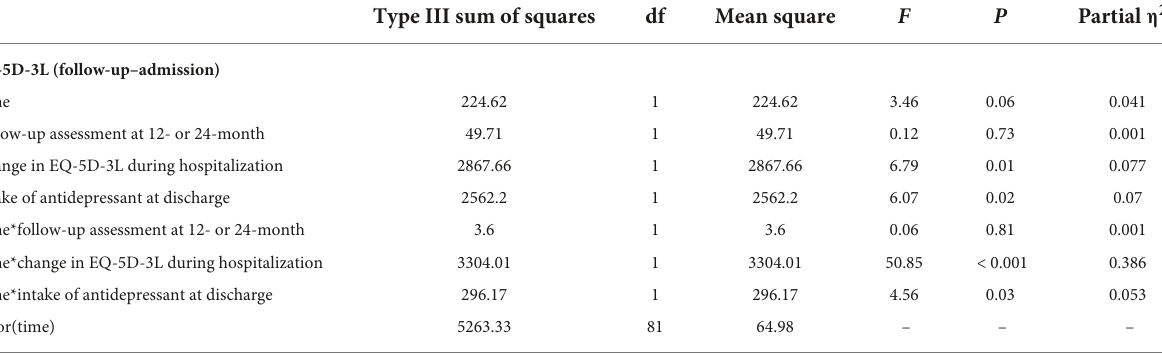
TABLE 4 Multi-factorial ANOVA with repeated measures showing factors associated with change in HRQoL between follow-up and admission. Type III sum of squares df Mean